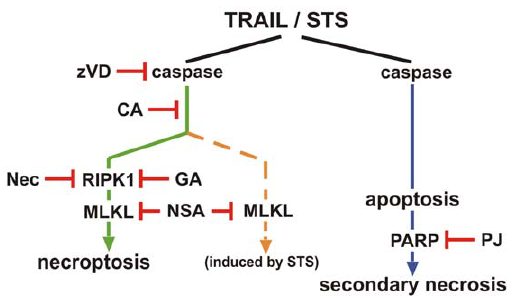
Figure 6. Schematic diagram about the action of inhibitors on TRAIL and STS- induced cell death pathways. Both TRAIL and STS triggered necroptosis in caspase depleted U937 cells upon prolonged incubation time. RIPK1 inhibitors Nec and GA could completely inhibit the TRAIL-evoked necroptosis, but had partial inhibitory potential to the STS-provoked process. Contrarily CA and NSA abolished both the TRAIL and STS-induced necroptosis. In absence of caspase inhibitor TRAIL and STS induced apoptosis which is followed by secondary necrosis. PJ-34 delayed the necrotic plasma membrane disruption during secondary necrosis, but failed to inhibit